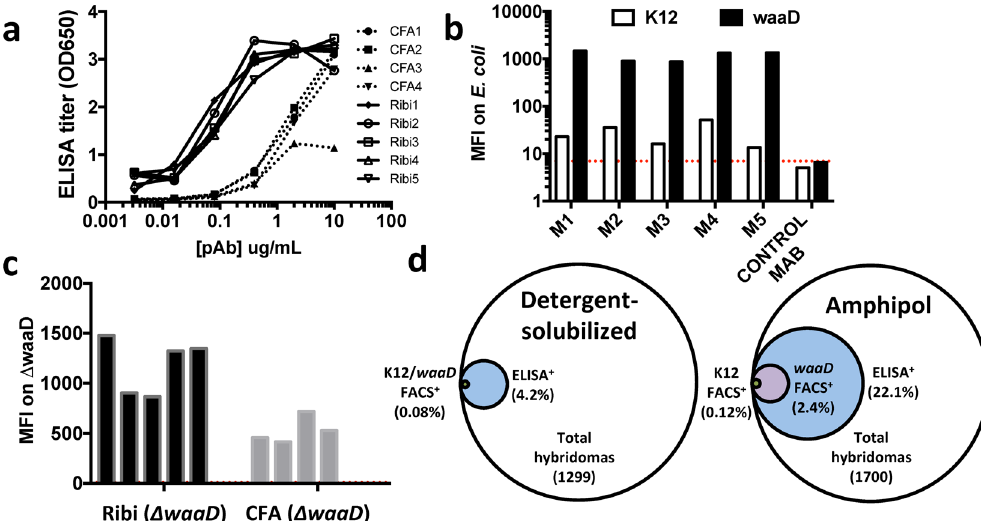
Figure 1. Immunization with amphipol-BamA and Ribi adjuvant generates robust antibody response. ( a ) Anti- BamA pAb titers using purified pAbs were measured by ELISA for BamA immunized mice with either Ribi (n = 5; solid lines) or CFA (n = 4; dashed lines) adjuvants. ( b ) Mean fluorescent intensity (MFI) as determined by flow cytometry of 40 μ g/mL BamA pAbs against Δ waaD (black box) or K12 strains (white box). M1-M5 represent individual mice from the Ribi immunized group. MFI for irrelevant antibody control is depicted by red dashed line. ( c ) MFI values for individual mice from either the Ribi adjuvant group (black box) or CFA adjuvant group (grey box). ( d ) Summary of ELISA and FACS results for panel of hybridomas from mice immunized with detergent-solubilized or